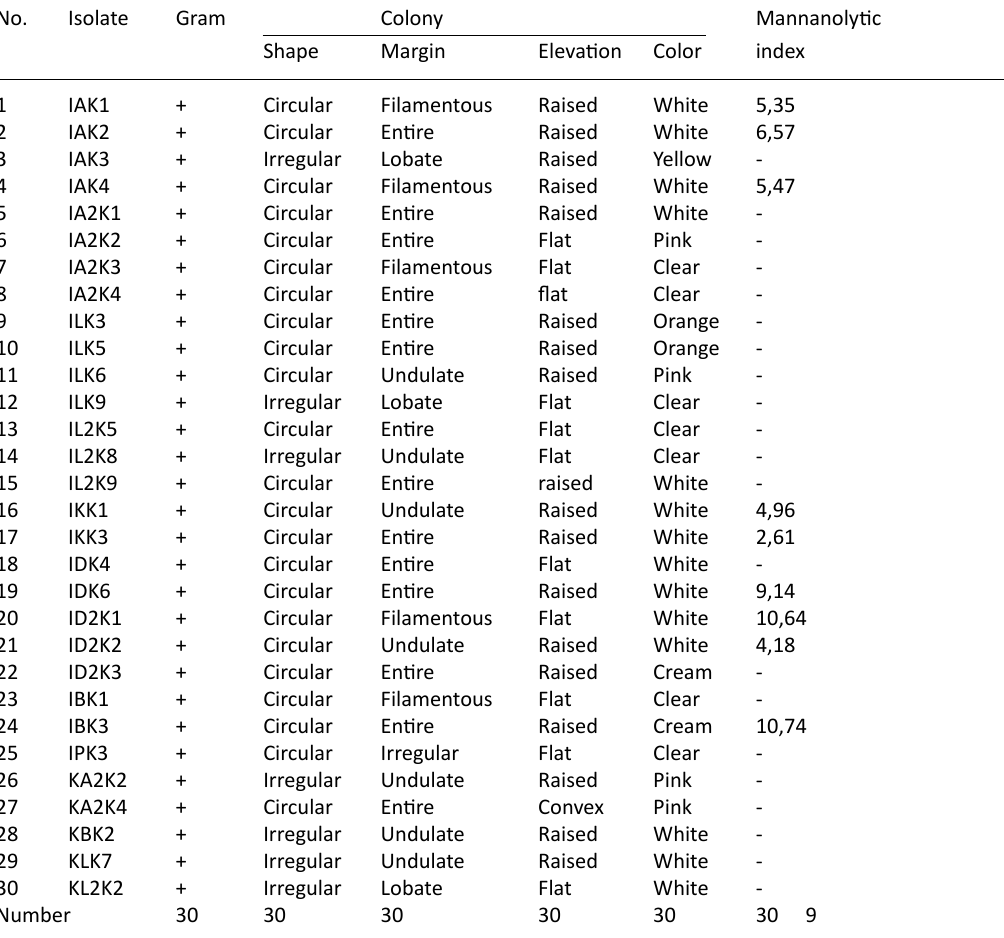
Table 1. Bacteria Selection and Characterization No. Isolate Gram Colony Mannanolytic